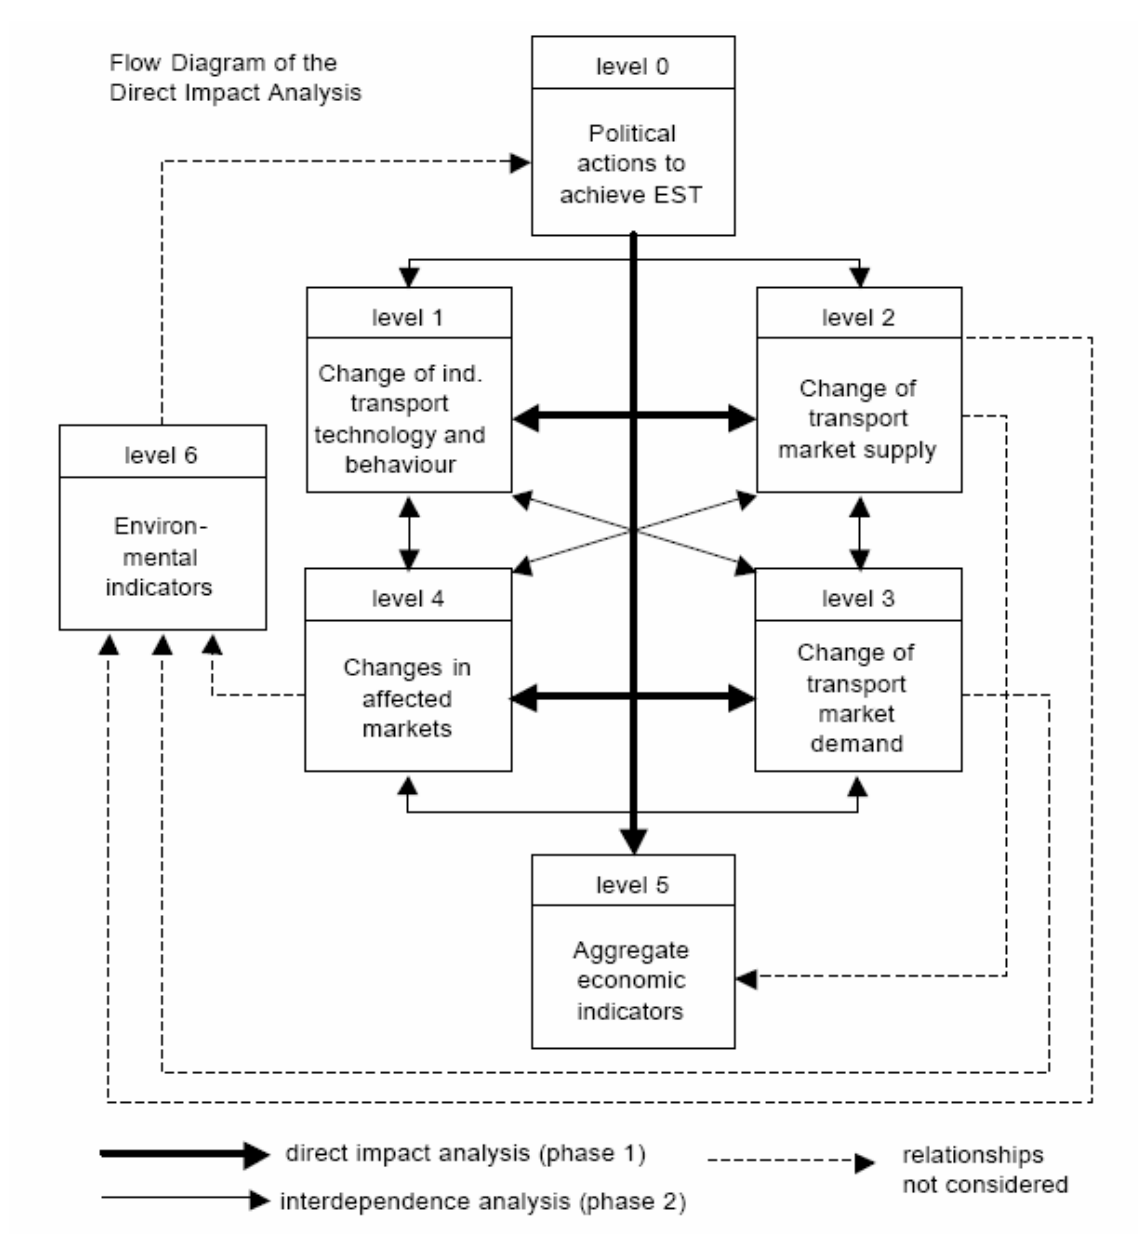
Figure 1. Flow Diagram of the Direct Impact